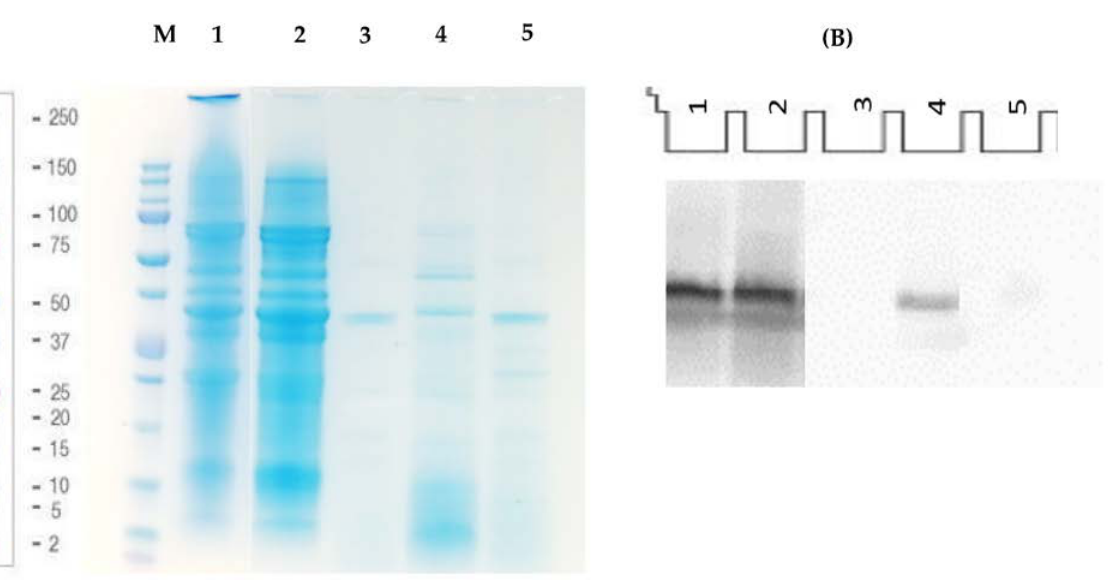
Figure 1. ( A ) SDS-PAGE electrophoresis analysis of (1) albumin-enriched soybean extract (ES, 50 µ g protein), (2) lunasin-enriched soybean extract (LES, 50 µ g protein), (3) control digest (CD, 50 µ g protein), (4) gastric digest from LES (GD, 50 µ g protein), and (5) gastrointestinal digest from LES (GID, 50 µ g protein). M: Precision Plus Protein Standard Unstained molecular weight marker. ( B ) Analysis of LES and its gastric and gastrointestinal digests by Western blot assay in PVDF membrane. (1) Synthetic lunasin (12.5 µ M), (2) LES (50 µ g protein), (3) control digest (CD, 50 µ g protein), (4) gastric digest from LES (GD, 50 µ g protein), and (5) gastrointestinal digest from LES (GID, 50 µ g